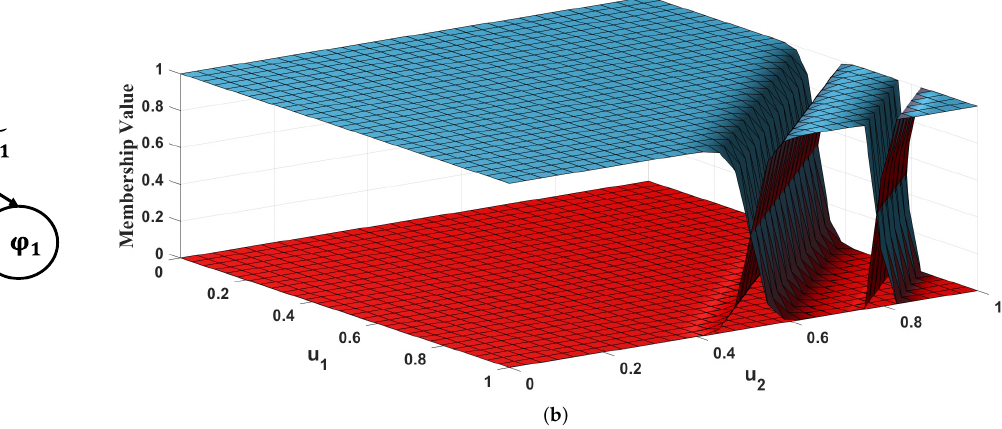
Figure 3. ( a ) The model tree and ( b ) the corresponding hierarchical